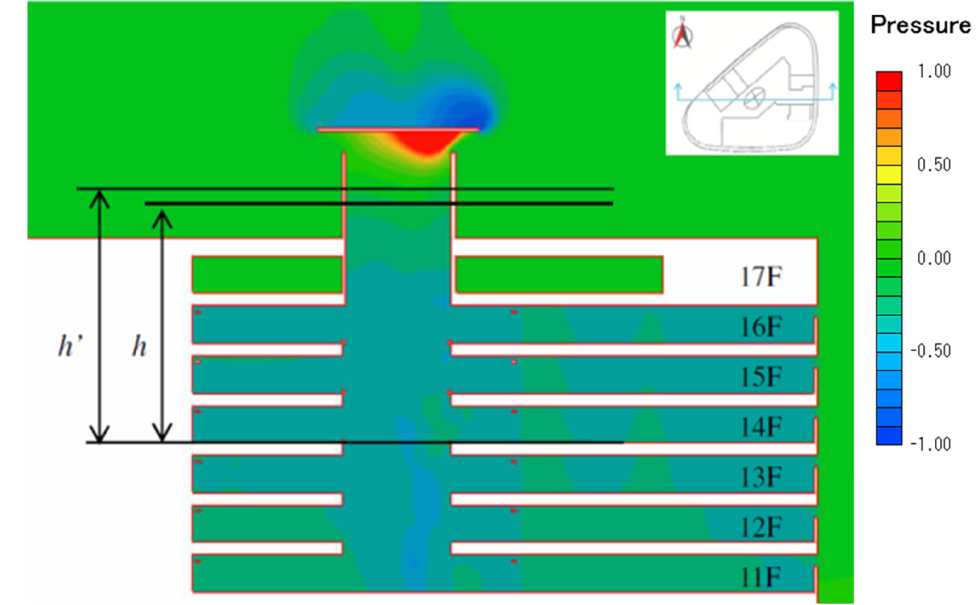
Figure 11. The comparison of neutral level between this study and Linden’s equation. Table 4. Comparison between present study and Linden’s equation.